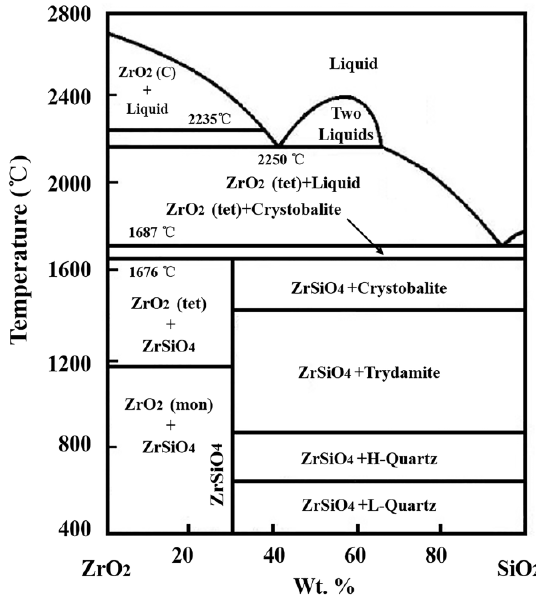
Figure 6. Thermal equilibrium phase diagram of SiO 2 ‐ ZrO 2 .